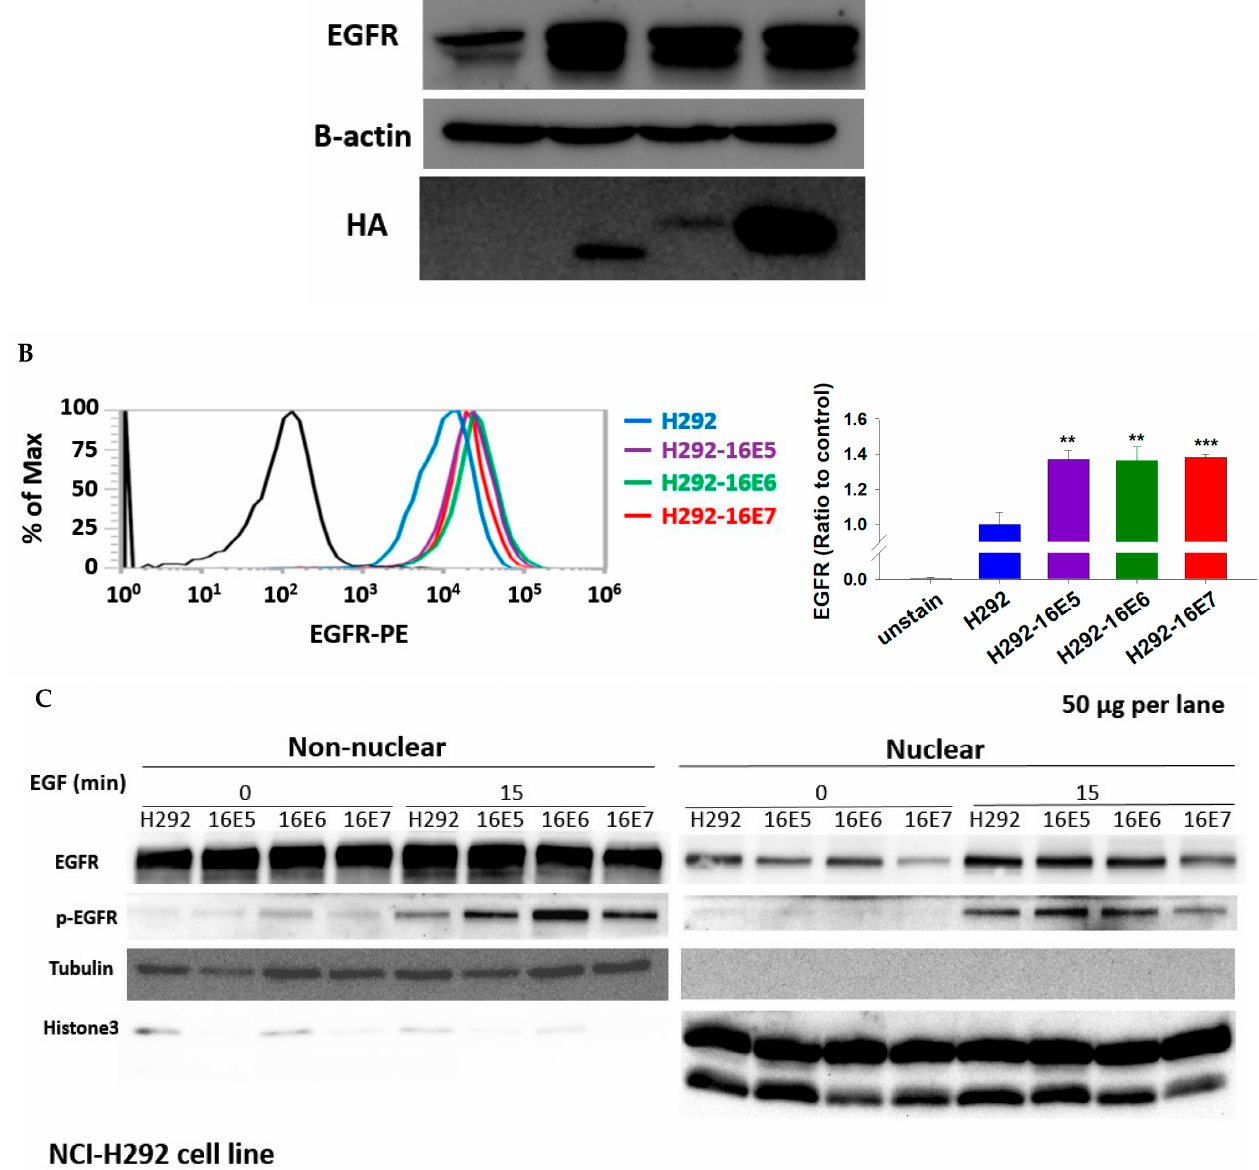
Figure 2. Epidermal growth factor receptor (EGFR) expression and EGFR nuclear translocation in transfected H292 − HPV16E5, H292 − HPV16E6, and H292 − HPV16E7 cells. ( A ) Immunoblotting to assess the efficiency of transfection and EGFR expression. Hemagglutinin (HA) was used to evaluate the transfection efficiency. B-actin was used as internal control. ( B ) Flow cytometry to assess differences in EGFR protein expression. ** p < 0.01; *** p < 0.001. ( C ) Increased phosphorylated EGFR nuclear and nonnuclear proteins after EGF 100 ng/mL stimulus for 15 min in transfected H292 − HPV16E5 and H292 − HPV16E6 cells. Tubulin and histone 3 were used as the internal control of nonnuclear and nuclear proteins, respectively. The uncropped blots are shown in Supplementary Figure S2.